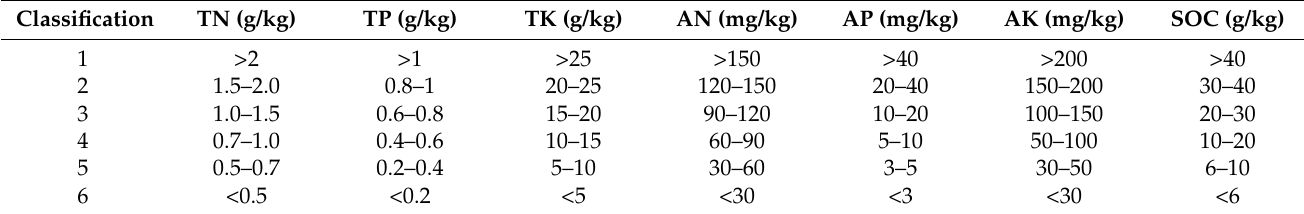
Table 6. Soil nutrient